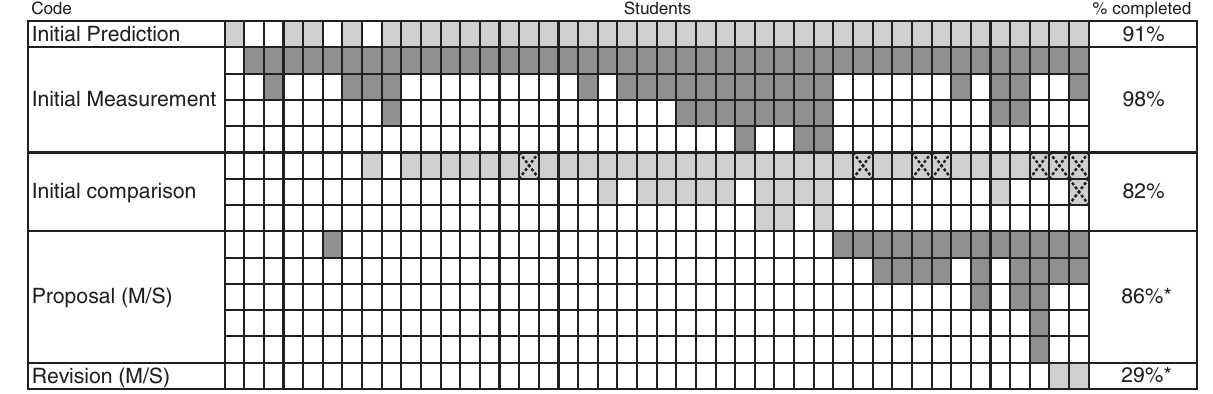
FIG. 9. Coding results for Activity 3. In total, 68% of the students completed the modeling process for the activity. Rows represent different steps in the modeling process and columns represent individual students. Each gray box represents a documented instance of the corresponding modeling step for the corresponding student. The X ’ s indicate comparisons that were evaluated to be in poor agreement. Percentages (*) for proposals and revisions were based on the total number of students whose comparisons indicated poor Fig. 9: 22 students documented more than one measurement and 12 students documented more than one comparison.